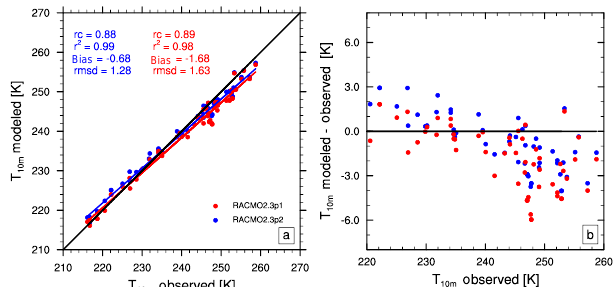
Figure 5. (a) RACMO2.3p2 (blue) and RACMO2.3p1 (red) and (b) modelled minus observed 10m snow temperature as a function of the 10m snow temperature observations. Denoted are the slope, determination coefficient r 2 , bias and root mean square deviation (RMSD) for both model